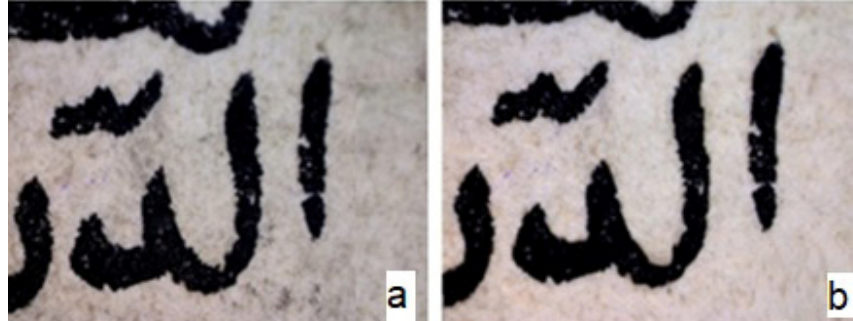
Figure 10. A fragment of antique Arabic manuscript: ( a )—before cleaning, ( b ) — after laser treat- ment.